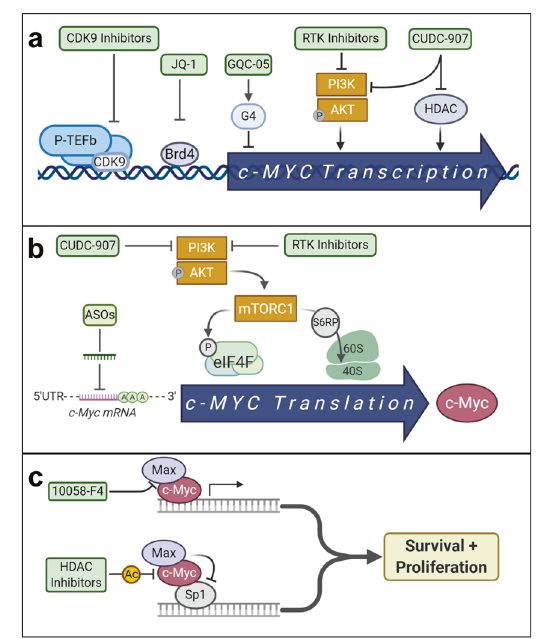
Fig. 5 Targeting c-Myc signaling in AML. a c-Myc ( MYC ) transcription is promoted through interactions with Brd4 and P-TEFb, which includes CDK9. Targeted therapies that suppress the initiation of transcription include the Brd4 inhibitor, JQ-1, and inhibitors of CDK9. Other inhibitors of c-Myc transcription include the G-quadruplex (G4) ligand, GQC-05, and the dual inhibitor of PI3K and HDAC, CUDC-907. Inhibitors of HDAC may work to inhibit c-Myc transcrip- tion through HDAC6, which stabilizes a transcription factor that in fl uences c-Myc expression. PI3K/AKT signaling also promotes c-Myc transcription and is inhibited via RTK inhibitors. b c-Myc translation is dependent on the formation of the translation- initiation complex, eIF4F, and the assembly of ribosomal subunit, 40S, which are both promoted through the activity of mTORC1. mTORC1 is indirectly suppressed through inhibition PI3K/AKT via RTK inhibitors and CUDC-907. Additionally, c-Myc translation is repressed via ASOs binding to c-Myc mRNA transcripts. c c-Myc promotes AML cell survival and proliferation and is reliant on interactions with its co-factor Max to promote transcription of survival signals. 10058-F4 inhibits the interaction of c-Myc and Max to prevent transcription and promote AML cell death. c-Myc represses Sp1, a transcription factor, to also promote cell survival. HDAC inhibitors induce acetylation of c-Myc to free Sp1 to promote cell